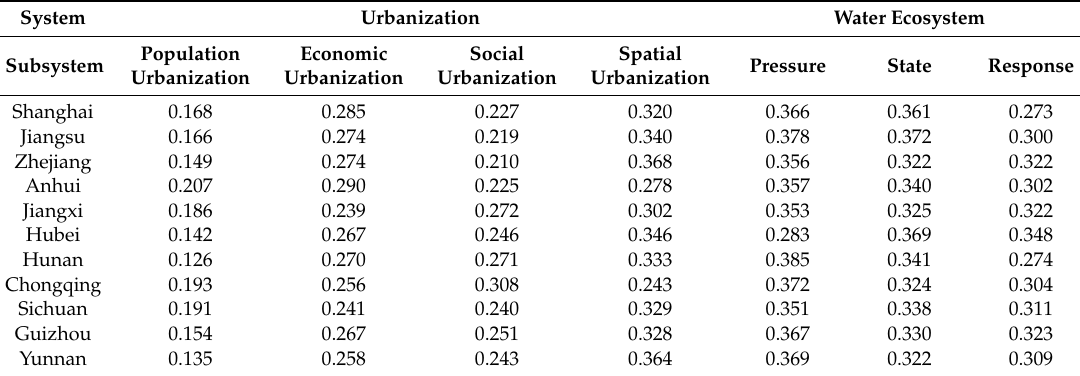
Table 4. Obstacle degree of subsystem in urbanization and water